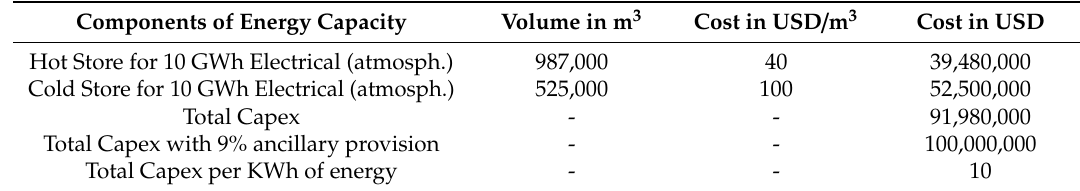
Table 2. Capex of Energy Capacity for the hybrid UPHES-PTES system. Components of Energy